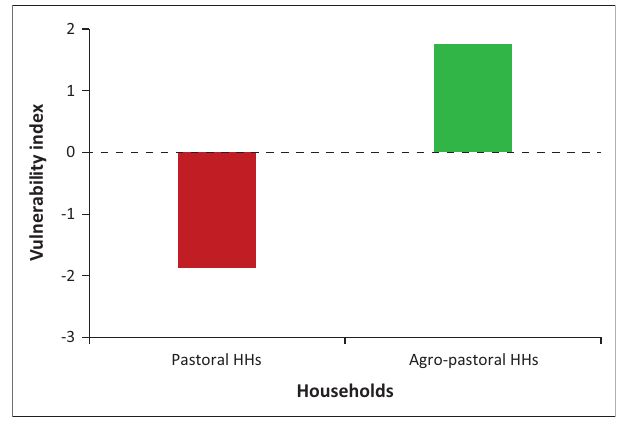
FIGURE 3: Vulnerability categories of households by livelihood strategy.